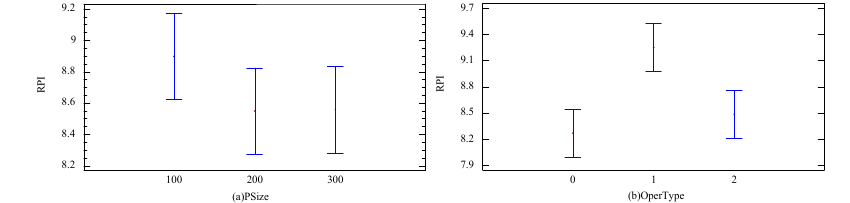
Fig. 5. Means plots for all factories for the ABC calibration.